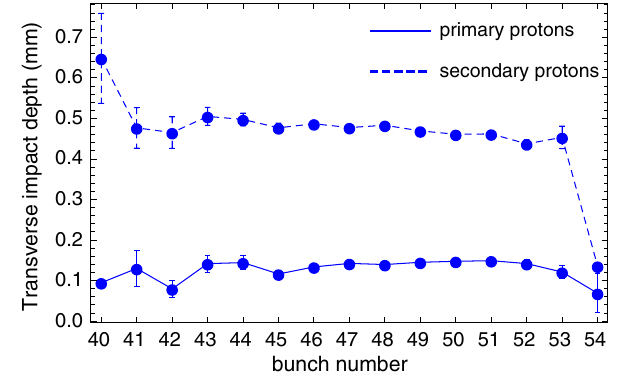
FIG. 11. Average transverse depth of impact from the edge of the collimator jaw given as a function of bunch number for Case 2. A bunch population of 1 . 3 × 10 11 p = b has been